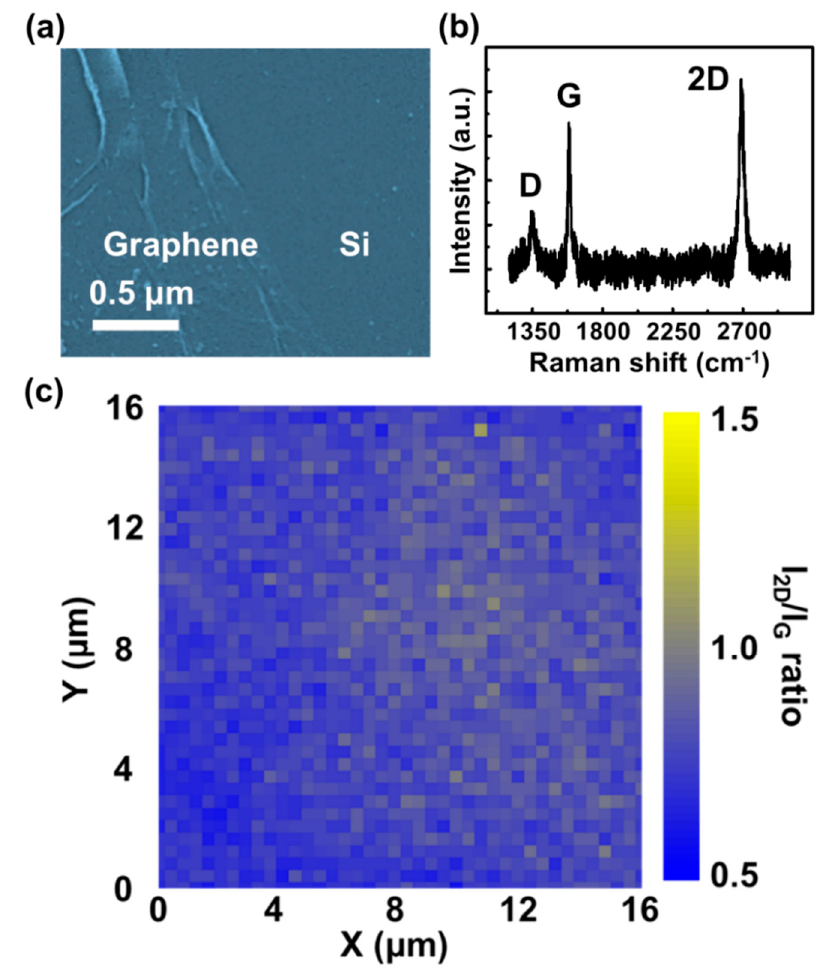
Figure 3. ( a ) Field emission scanning electron microscope (FESEM) image and ( b ) Raman spectra and ( c ) I 2 D / I G Raman mapping of the bilayer graphene on a p-Si substrate (excitation laser:532 nm).